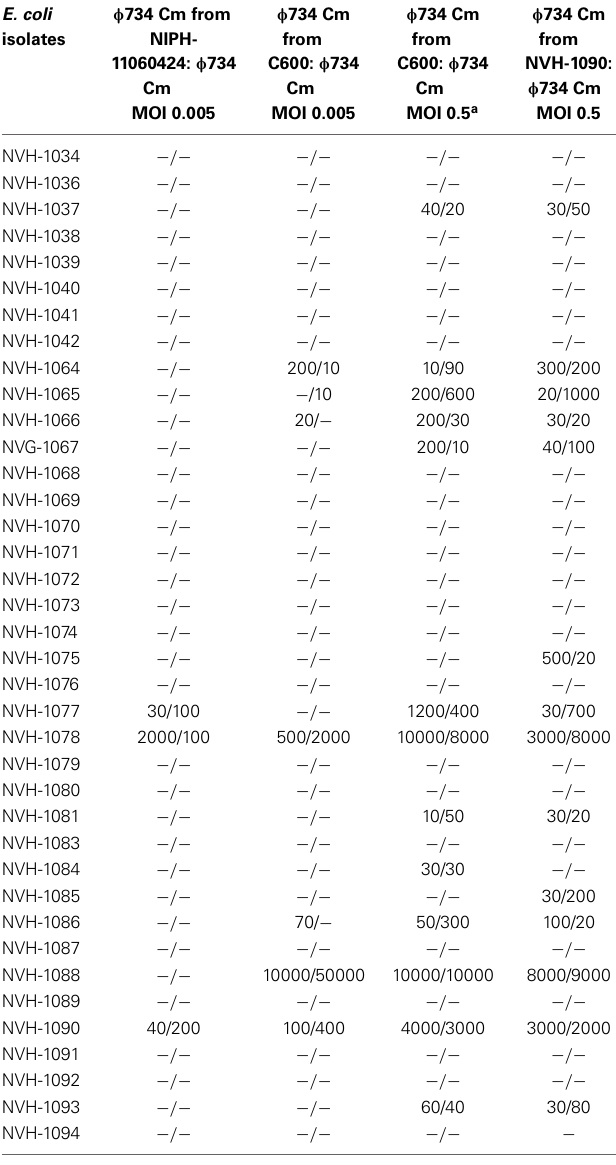
Table 3 | Susceptibility of 38 commensal E. coli strains to lysogenic infection by the φ 734 Cm